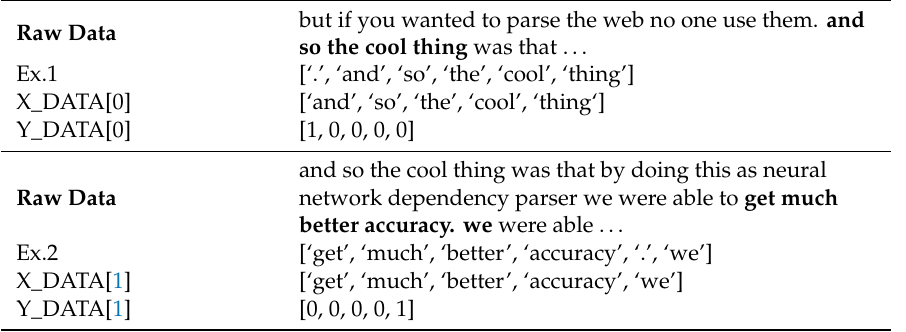
Table 2. Examples of preprocessed